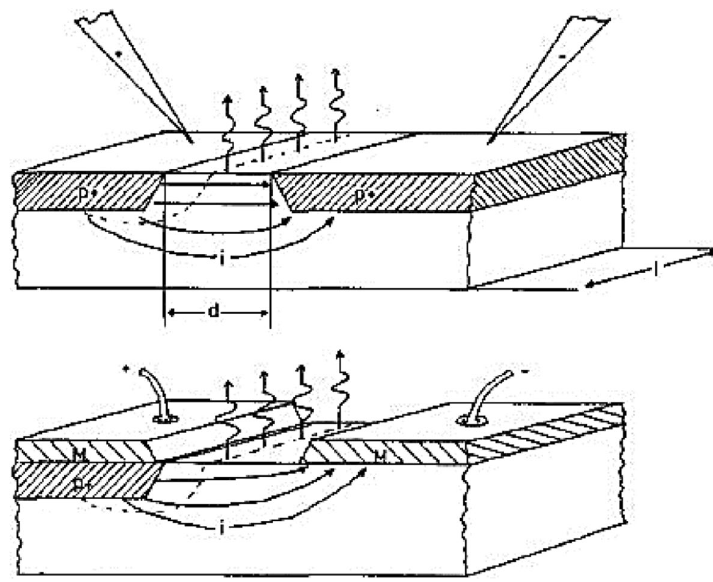
Fig. 5 Diagram of the fabricated diamond LEDs: a p + -i-p + ; b M -i -p + (with metallization). Reproduced with permission [11], Copyright 1994, Elsevier